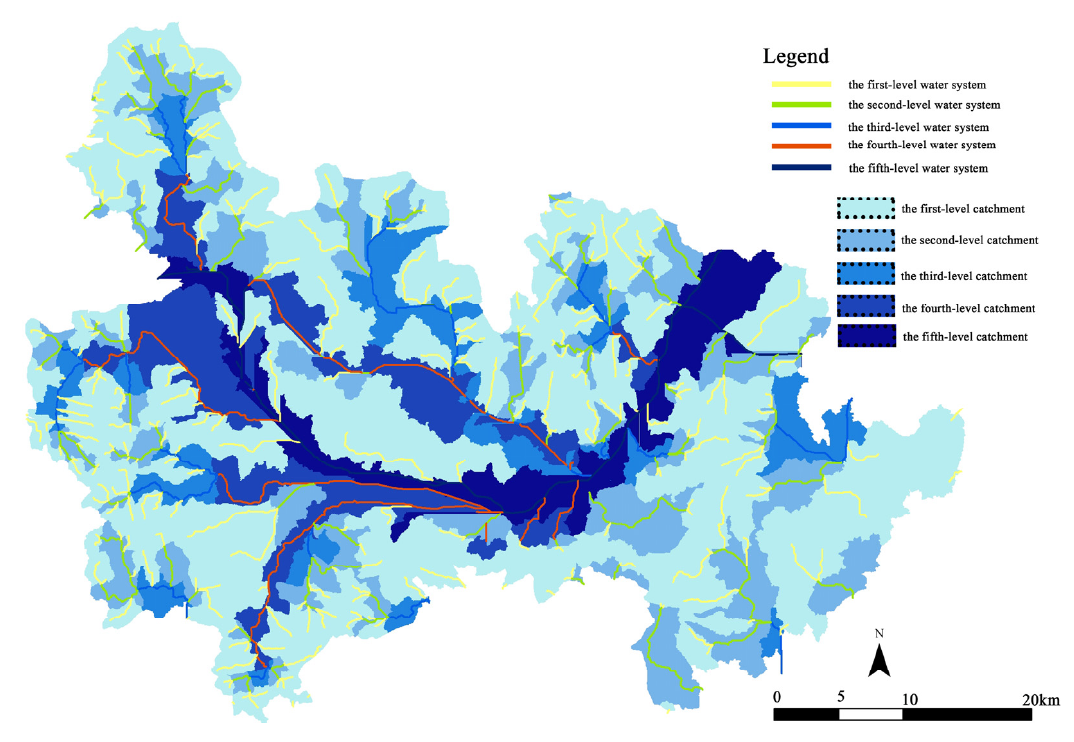
Figure 6. Semi-natural catchment spatial distribution. Table 3. Catchment area of administrative